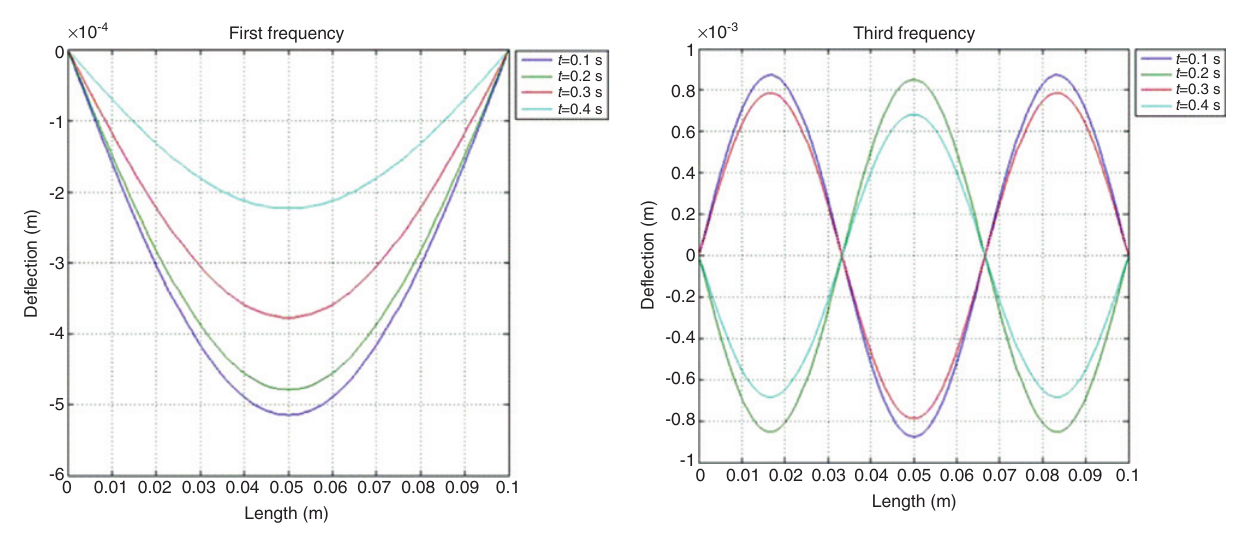
Figure 6: Vibrations of the first characteristic mode of the simply supported